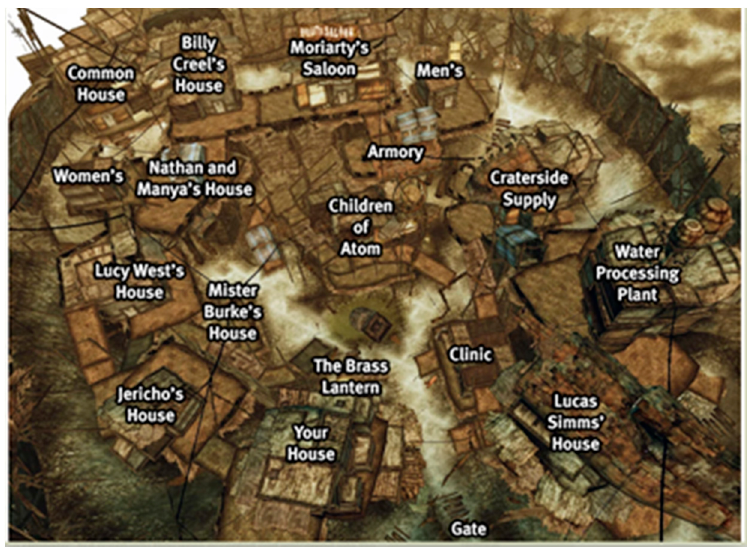
Figure 2. Megaton’s map ( Fallout Wikia n.d.).